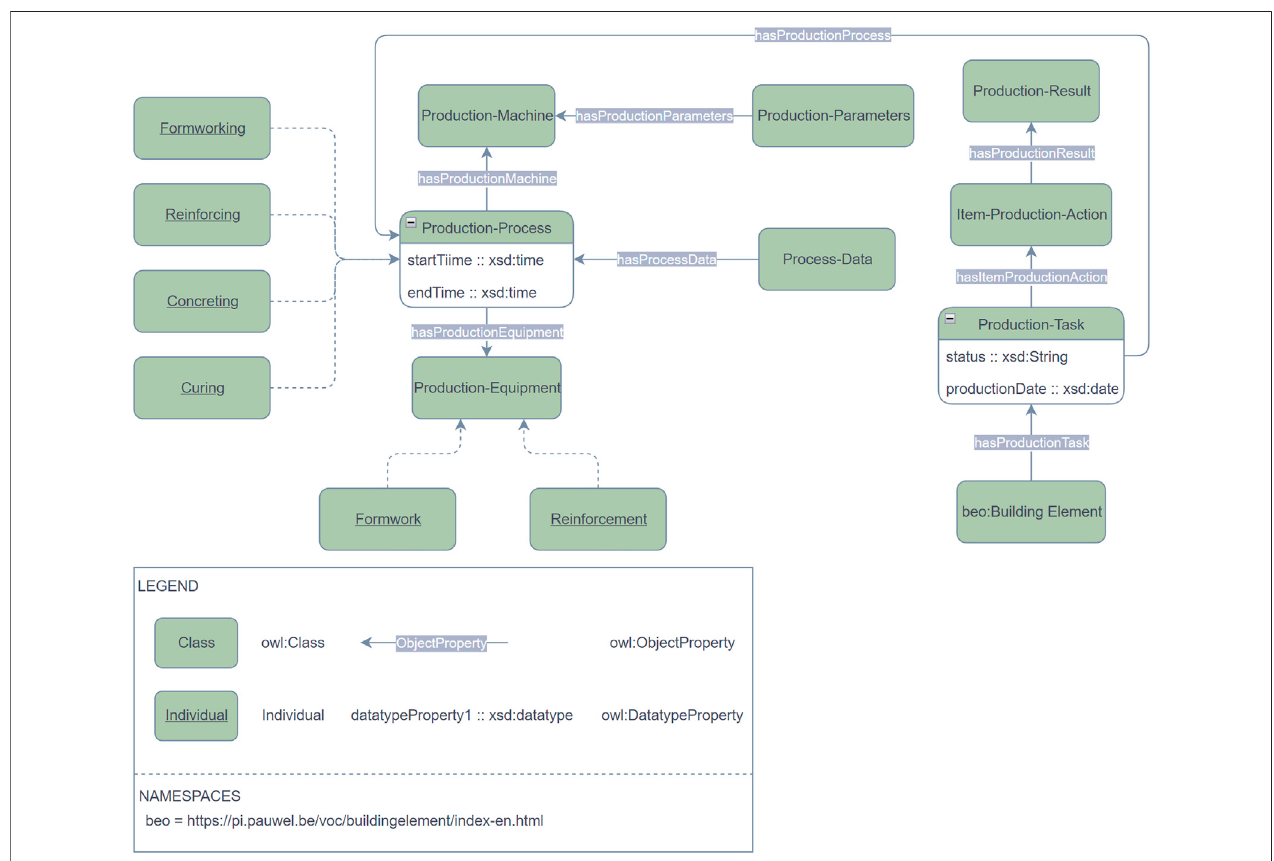
FIGURE 5 | Metamodel for the ontology of the production